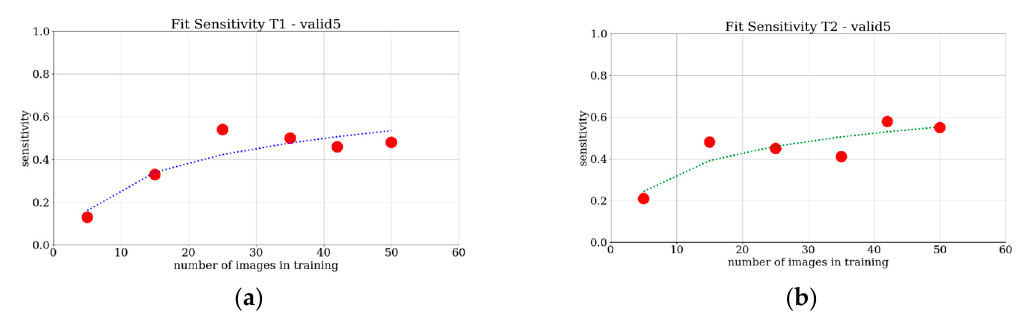
Figure 17. Real values (red dots) and fitting curves (dotted line) of sensitivity analysis: ( a ) for T1 with valid5 and threshold equal to 0.9; ( b ) for T2 with valid5 and threshold equal to 0.9.